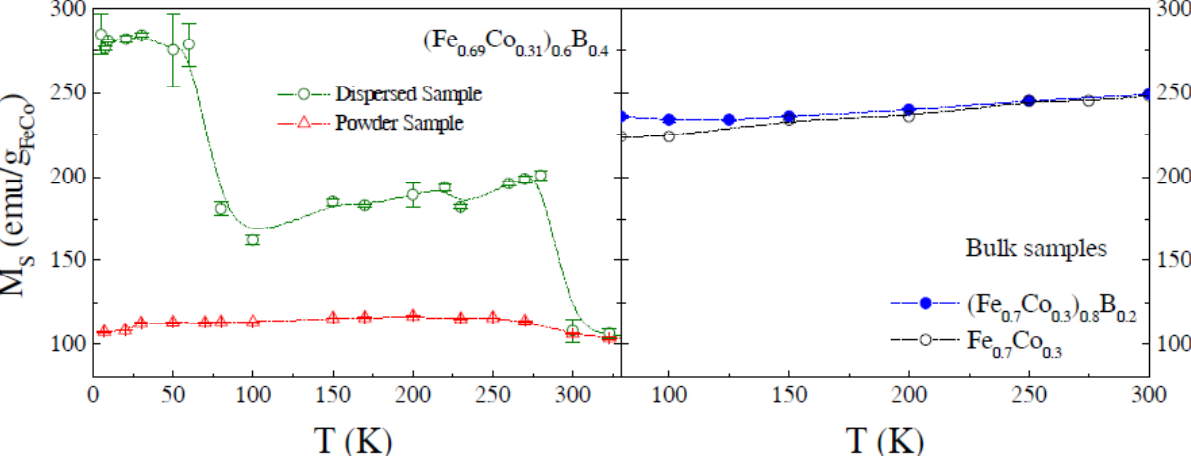
) vs. temperature for dispersed (non-interacting) Figure 5. Saturation magnetization ( M S and powder (with strong interparticle interactions) (Fe Co ) B and Fe Co samples. The lines are only a guide for the (Fe 0.7 0.3 0.8 0.2 0.7 0.3